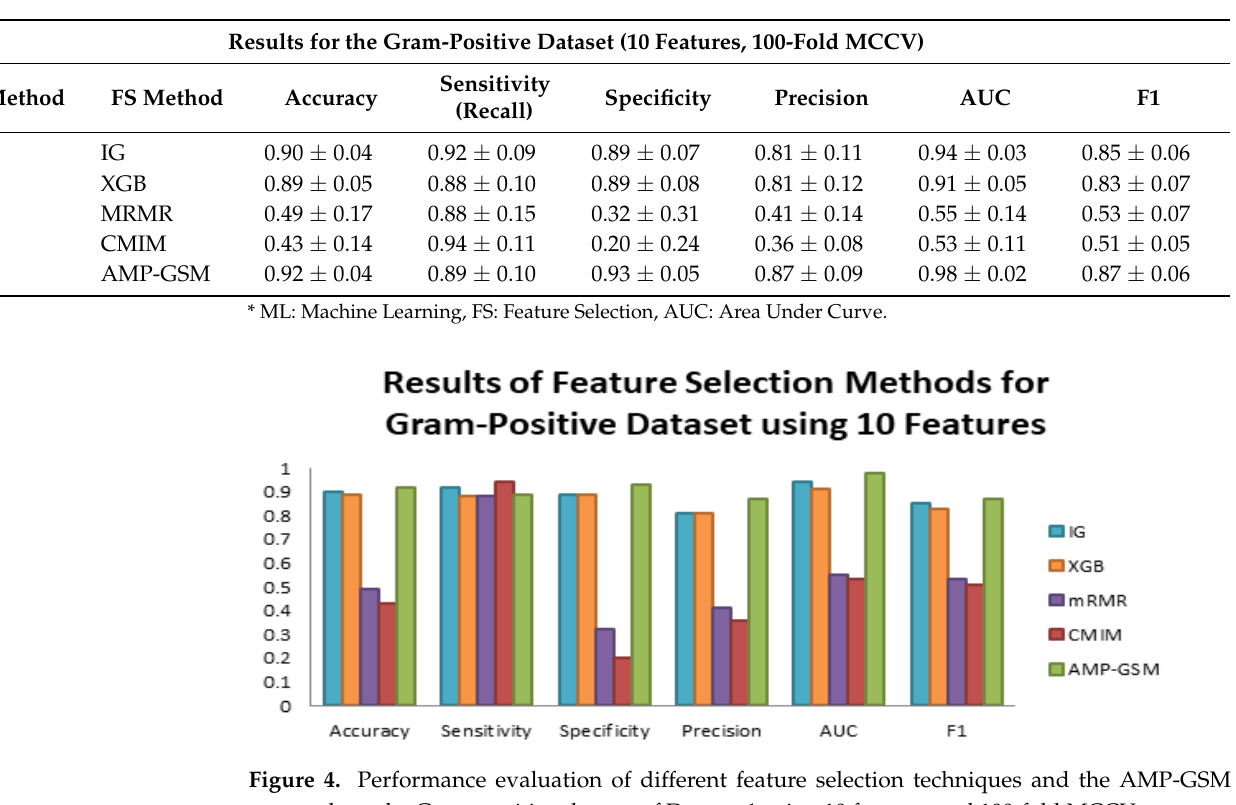
Table 7. Performance metrics of different feature selection techniques with 10 features on the Gram- positive dataset of Dataset 1, using 100-fold MCCV *.